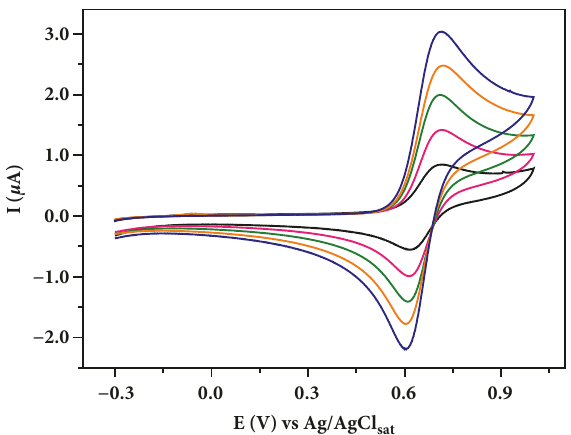
Figure 2: Cyclic voltammograms of potassium ferroferricyanide in 2.0 mol L −1 H 2 SO 4 using GE (scan rate: 100 mV s −1 ).